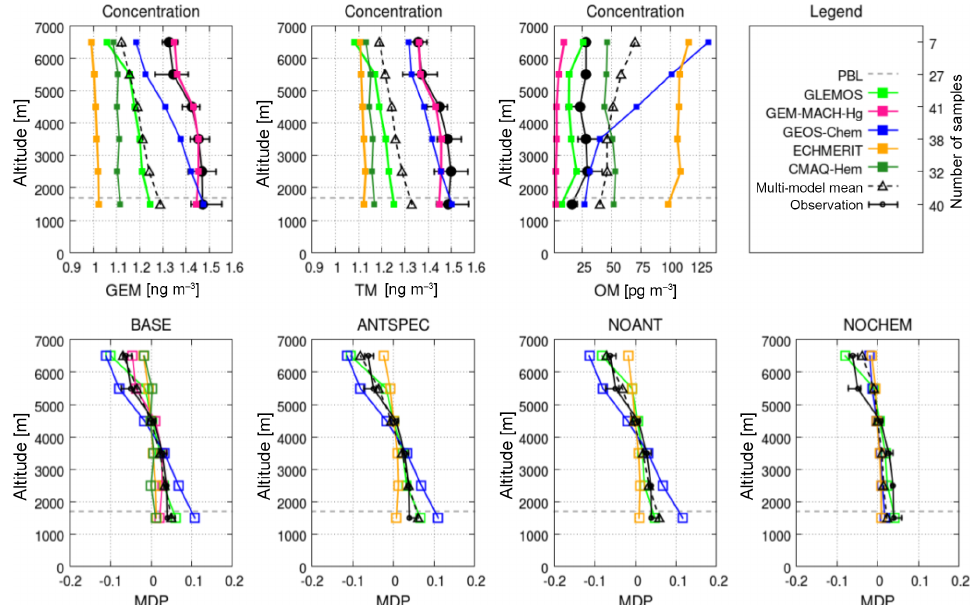
Figure 4. Comparison of modelled average mercury profile for North America to observations based on vertical profiles at Tullahoma, TN, from January and February 2013 (Brooks et al., 2014). The error bars indicate the 66% quantile range of the observations in each altitude; the sample size for each altitude is indicated on the y axis of the legend. The mean deviation profiles (MDP) are given for